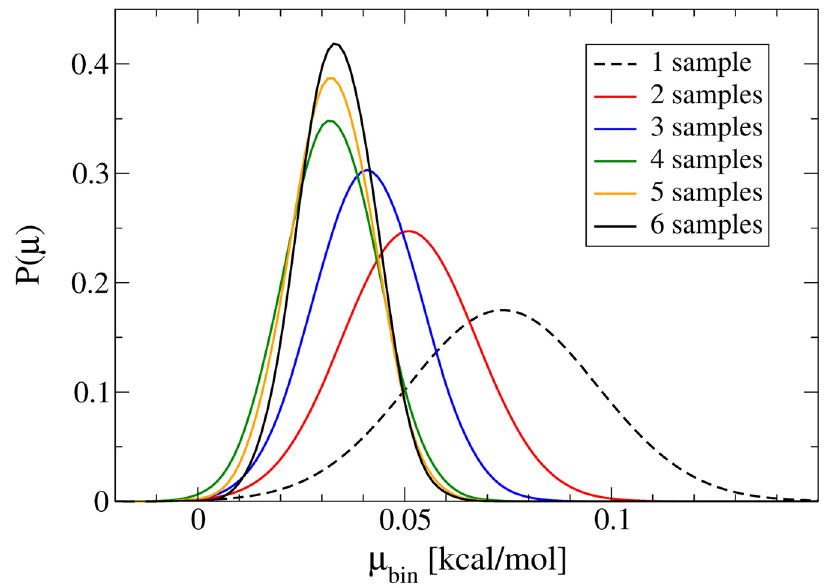
Fig 9. A representative example of the progression of probability densities through Bayesian inference, showing the bin at z = 2.0 Å for O 2 at 323 K. All means started equally probable, and each plot represents one new sample of h W rev i (i.e. the evidence) added to the hypothesis. The predicted mean values of h W rev i shown in the distributions are denoted by μ bin